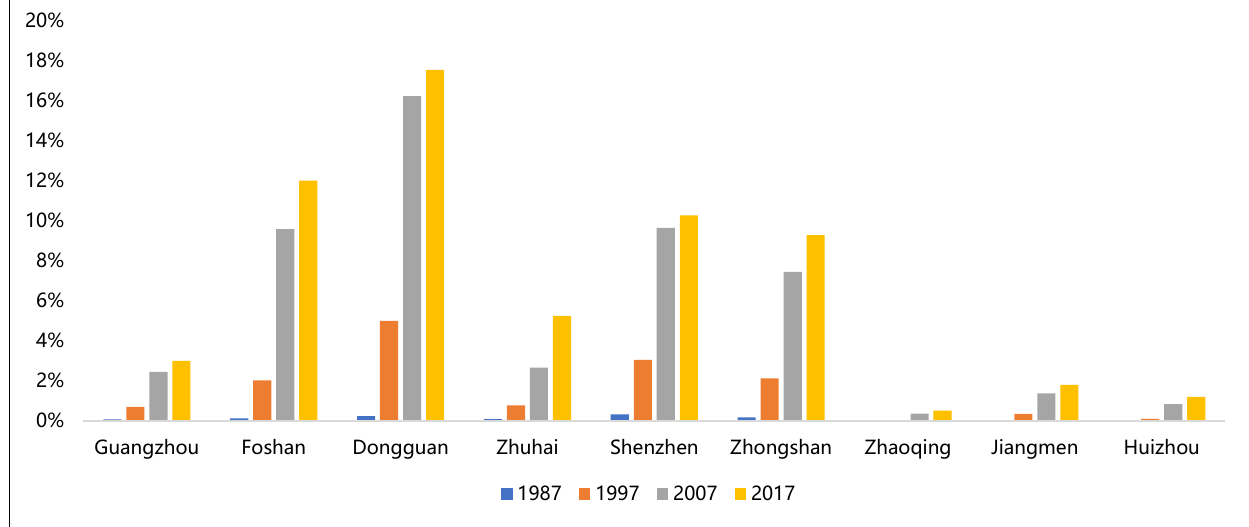
Figure 7. Density index of manufacturing production spaces in each city from 1987 to 2017.